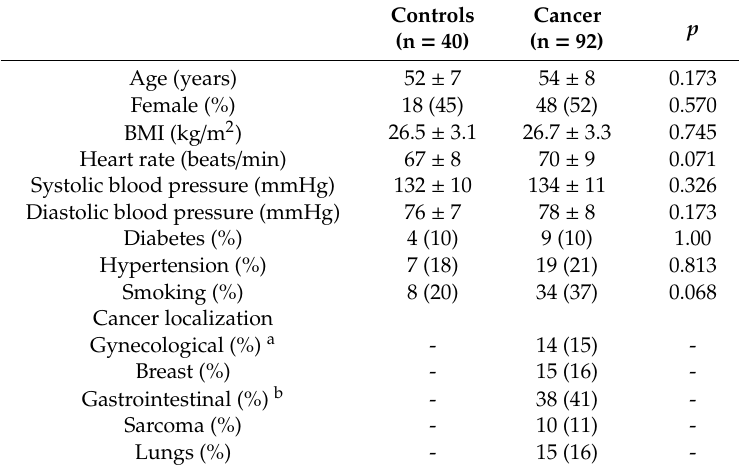
Table 1. Demographic characteristics and clinical parameters of study population